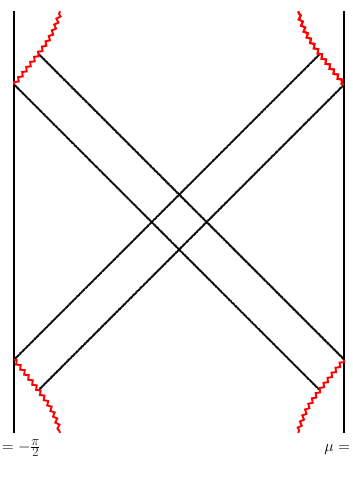
Figure 1 . The Penrose diagram for the Janus deformation is